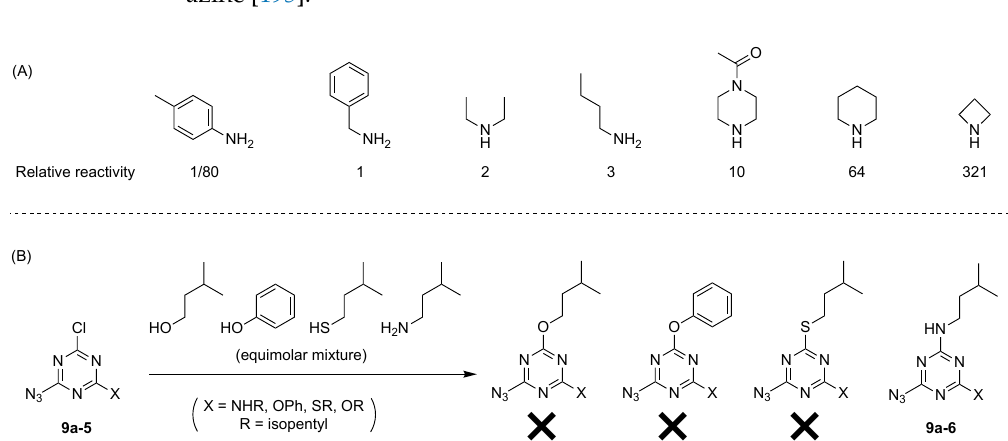
Figure 33. Relative reactivity of amines in nucleophilic substitution of triazine chlorides ( A ). Competitive reactions of various nucleophiles for chlorotriazines ( B ).